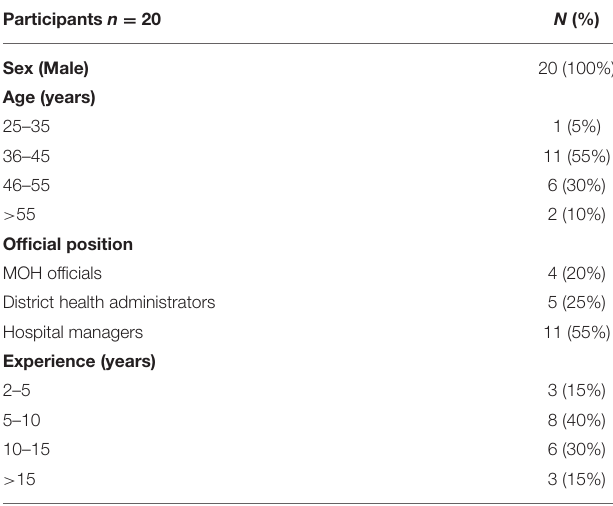
TABLE 1 | Characteristics of the study’s participants ( N =